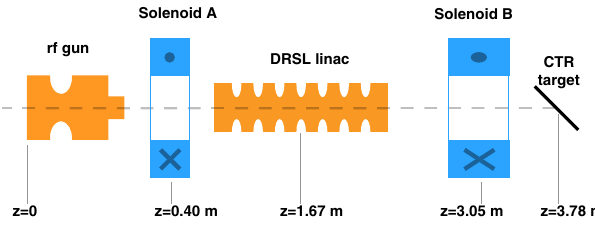
FIG. 1. Schematic of beam line for velocity bunching experi- ment (drawing not to